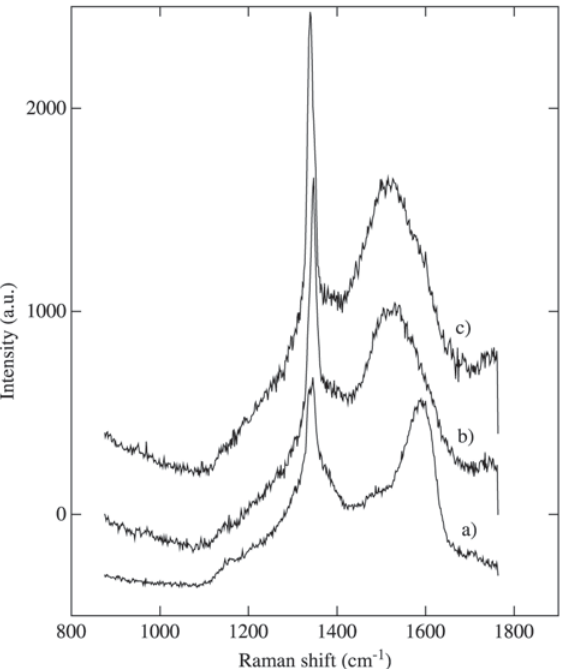
Figure 2. Raman spectra for boron-doped diamond in: a) non-per- forated sample; b) between two holes on perforated sample; c) near to a hole on perforated sample.